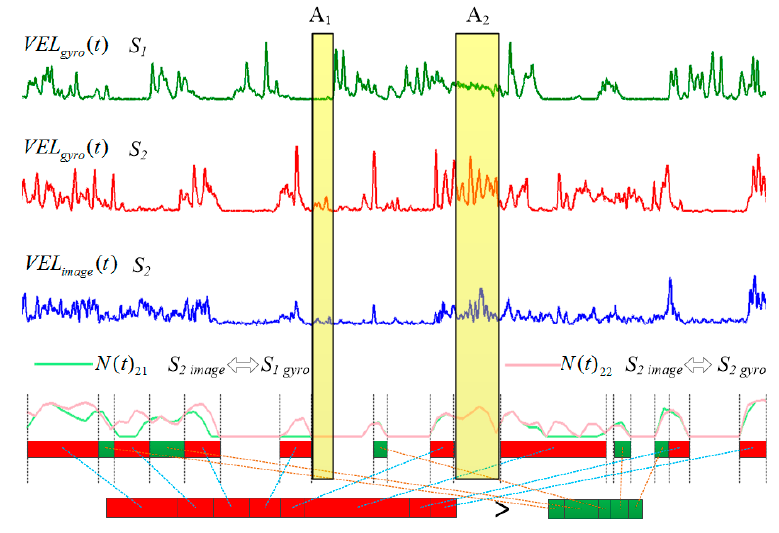
Figure 7. Mapping process from two subjects.